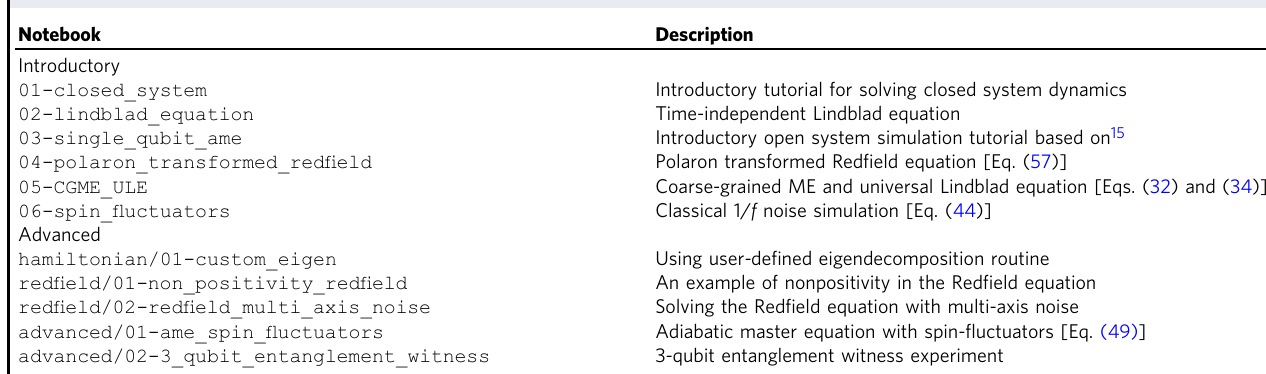
Table 3 List of tutorials for